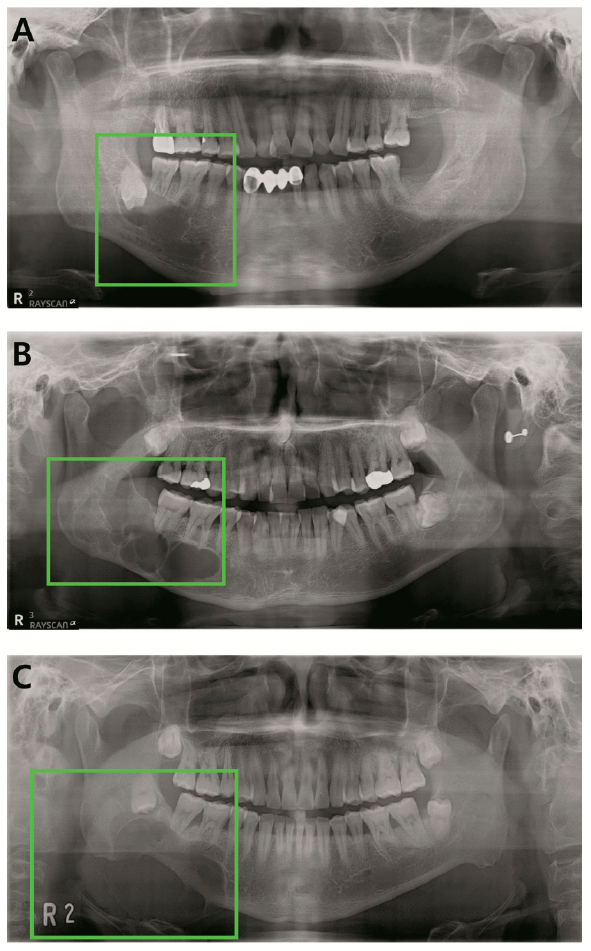
Figure 1. Examples of the included lesions. ( A ) Dentigerous cyst, ( B ) odontogenic keratocyst (OKC), ( C ) ameloblastoma.